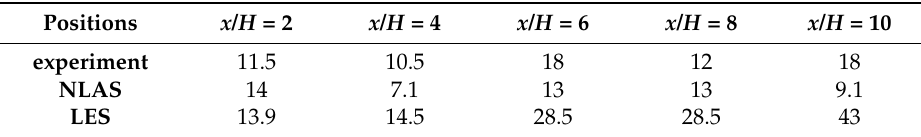
Table 1. Maximal sound pressure level (decibel, dB), where x is the distance from the probe to the step, and H is the height of the step. Positions x / H = 2 x / H = 4 x / H = 6 x / H = 8 x / H = 10 experiment − 26 − 27 − 24.2 − 22.6 − 24 NLAS − 26 − 23 − 24.35 − 21.7 − 23.2 LES − 26.27 − 25.2 − 23.04 − 18.6 − 19.54